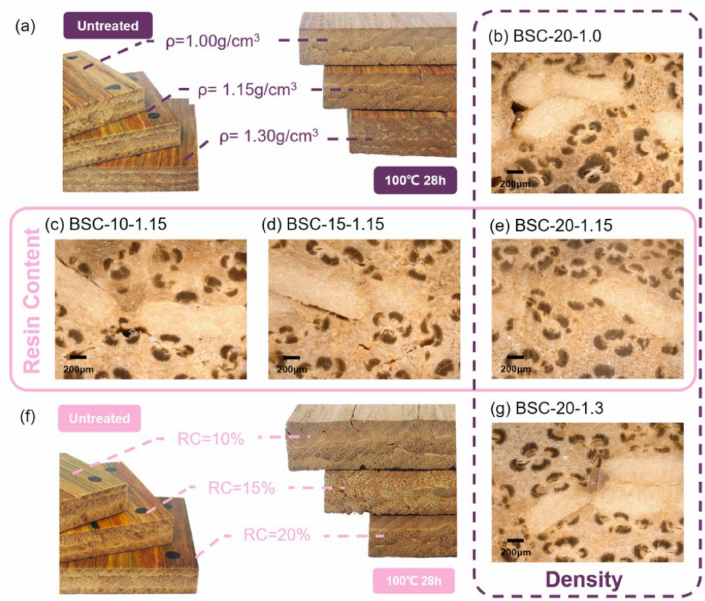
Figure 8. Images of BSC samples at various density ( a ) and resin content ( f ) conditions before and after the water-resistance test and failure morphologies at the inner-to-inner bonding interfaces of the BSCs ( b – e , g ) after the 28-h cycle treatment. Note: The pink frame represents BSCs at various resin contents; the purple frame represents BSCs at various